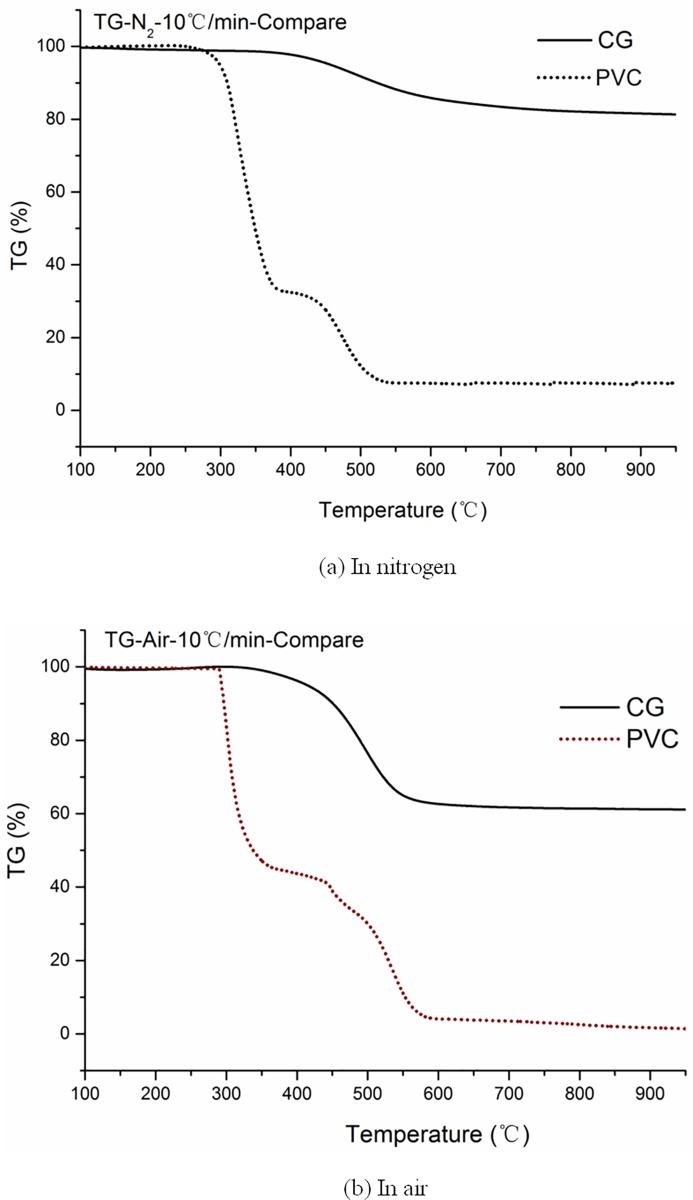
Thermogravimetry curves of combustion and pyrolysis for coal gangue (CG) and polyvinyl chloride (PVC) in (a) nitrogen and (b) air.